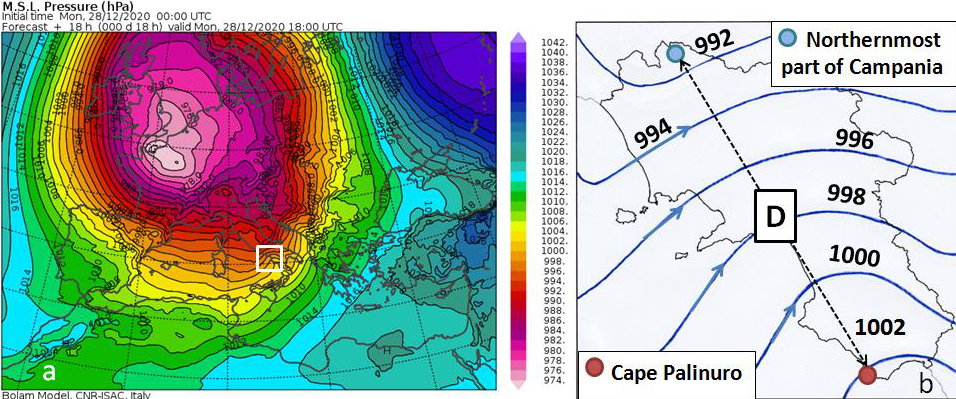
Figure 6. ( a ) Sea Level Pressure forecasting map valid for 28 December 2020 H18:00 UTC (BOLAM Model [45]); ( b ) map highlighting the high horizontal gradients over Campania region.